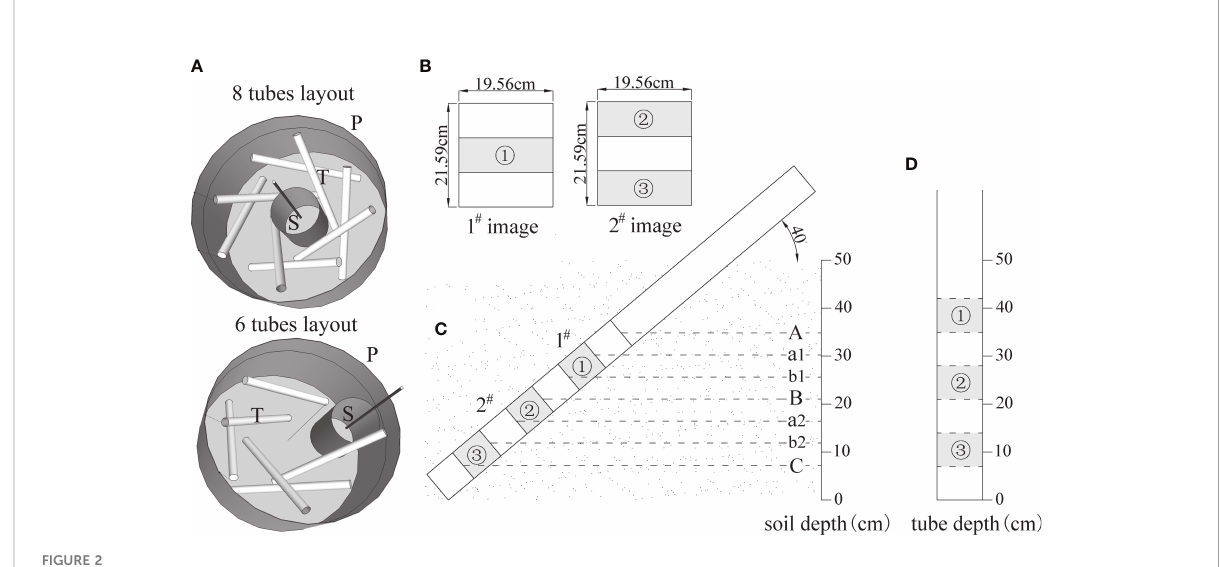
FIGURE 2 Minirhizotron tube layout, image subsample belt design, and corresponding soil layers. (A) rhizotron tubes layout, in which 8 tubes were arranged for ITT, HCT, CK, and 6 tubes for BRT; P ~ container, T ~ rhizotron tube, S ~ planting site; (B) distribution of subsample belts; (C) image location; (D) depth of subsample belts in tube; (A, B) are the top and bottom lines of the 1 # image; (B, C) are the top and bottom lines of the 2 # image; a1 and b1 are the three-equal-division lines in 1 # image; a2 and b2 are the three-equal-division lines in 2 # image; ① - ③ are the three subsample belts from top to bottom in one tube.